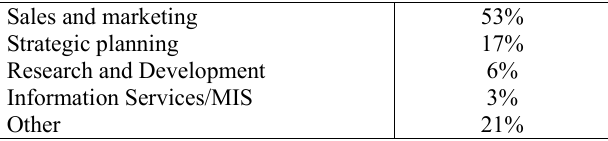
Table 3: Department responsible for CI Sales and marketing